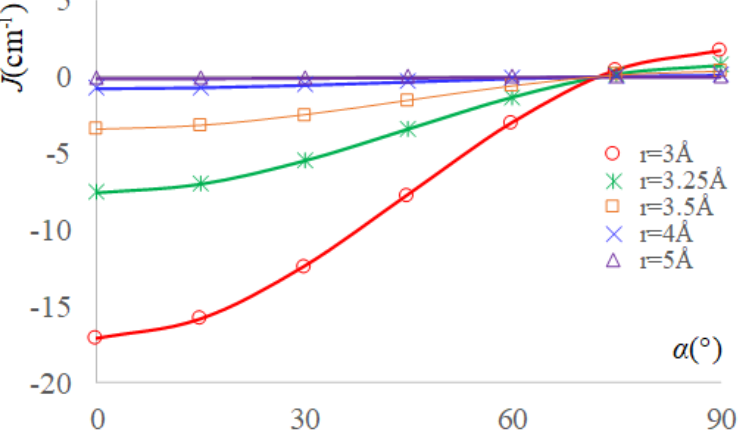
Figure 4. The exchange integrals as function of the α angle (see the scheme from Figure 1) between the p-type lobes in case of a TEMPO dimer with coaxial NO groups. The marked points correspond to BS-DFT computed data, the continuous lines being emulated with the Equation (8), based on the previously fitted J F ( r ) and J 0 AF (𝑟) parameters (red line for r =3 Å, green line for r =3.25 Å, orange line for r = 3.5 Å, blue line for r = 4 Å, purple line for r = 5 Å). Note that the representation does not imply an underlying fitting procedure.